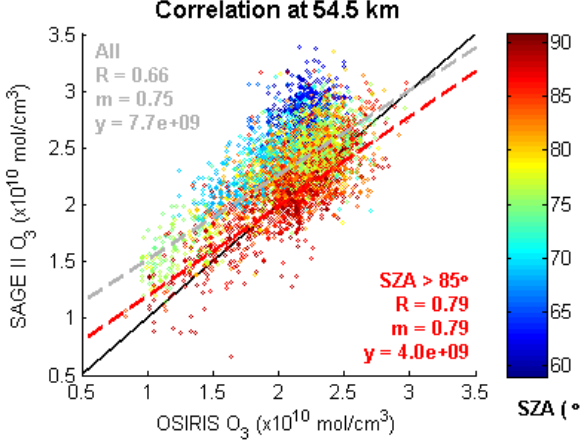
Figure 8: Correlation plot of OSIRIS versus SAGE II ozone number densities at 54.5 km altitude. The color scale indicates the SZA of the OSIRIS measurements. Linear fits (dashed lines) and fitting statistics (text) are indicated for all coincidences (grey) and for coincidences with OSIRIS measurement SZA > 85° only (red). The R correlation coefficient is indicated by R, the slope is indicated by m, and the y-intercept is indicated by y. The black line indicates 1-1. Measurement pairs were selected for broad coincidence criteria (see Table 1).